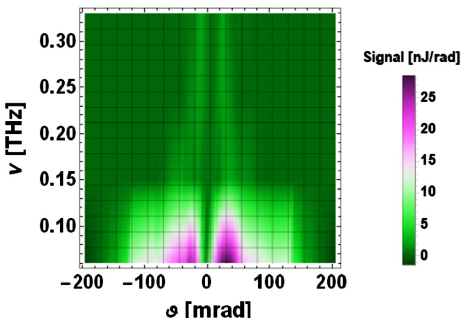
FIG. 4. Smoothed representation of the experimental results on spectral-angular characterization of the CTR light emitted by a 215 MeV, 40 pC, 1.5 ps long electron bunch at 30 cm from the source.